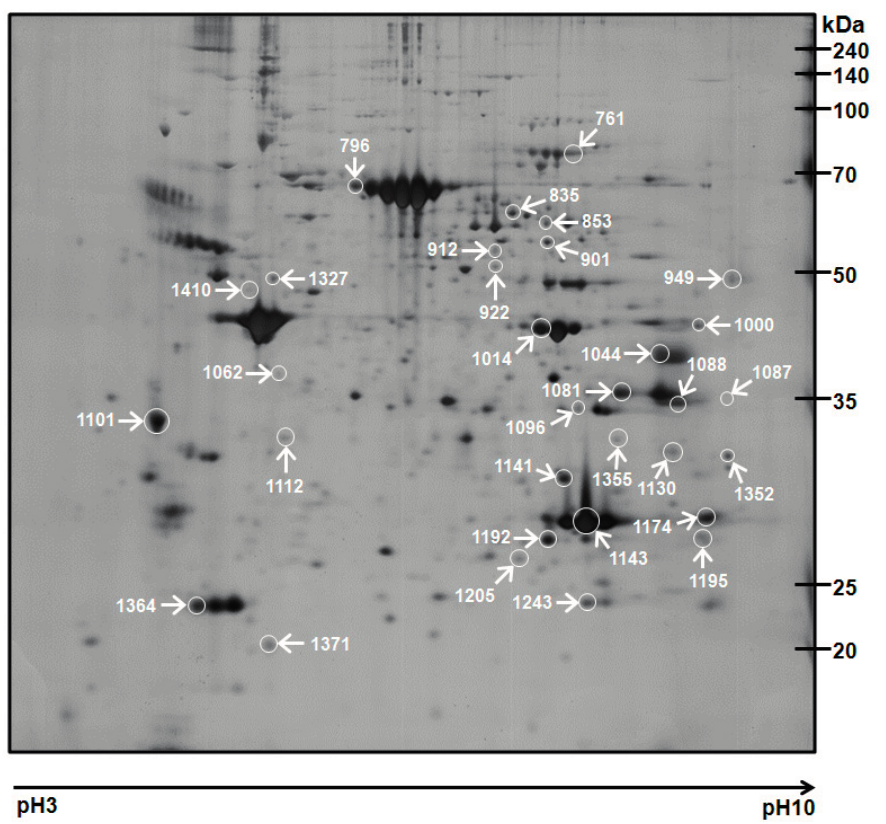
Figure 2. Representative silver-stained two-dimensional electrophoresis (2-DE) gel image of WAT proteome. Differentially regulated proteins are marked with white